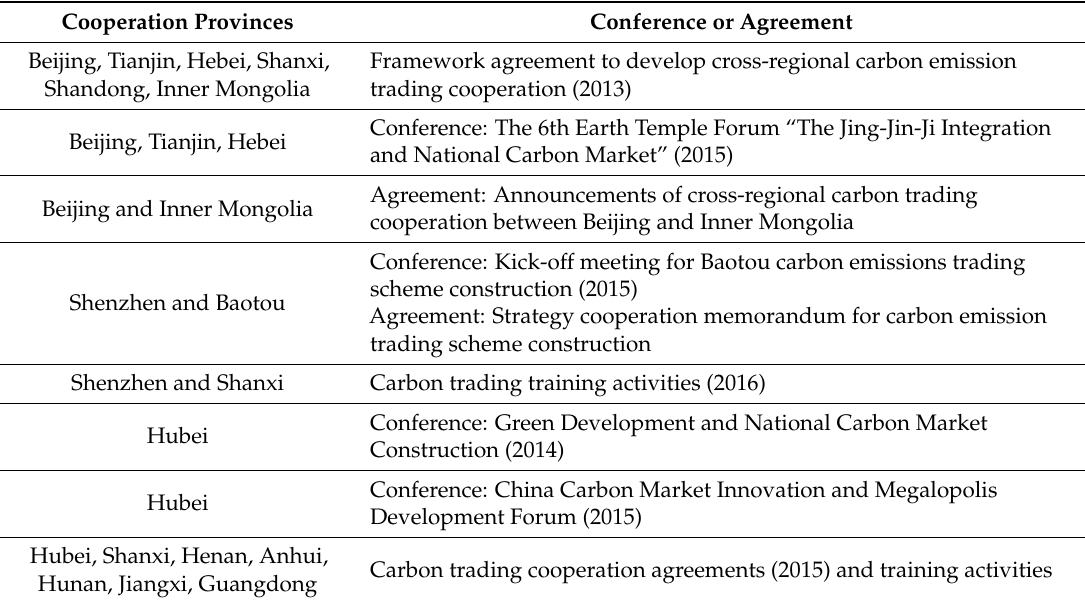
Table 10. Carbon emission trading cooperation in China’s pilot